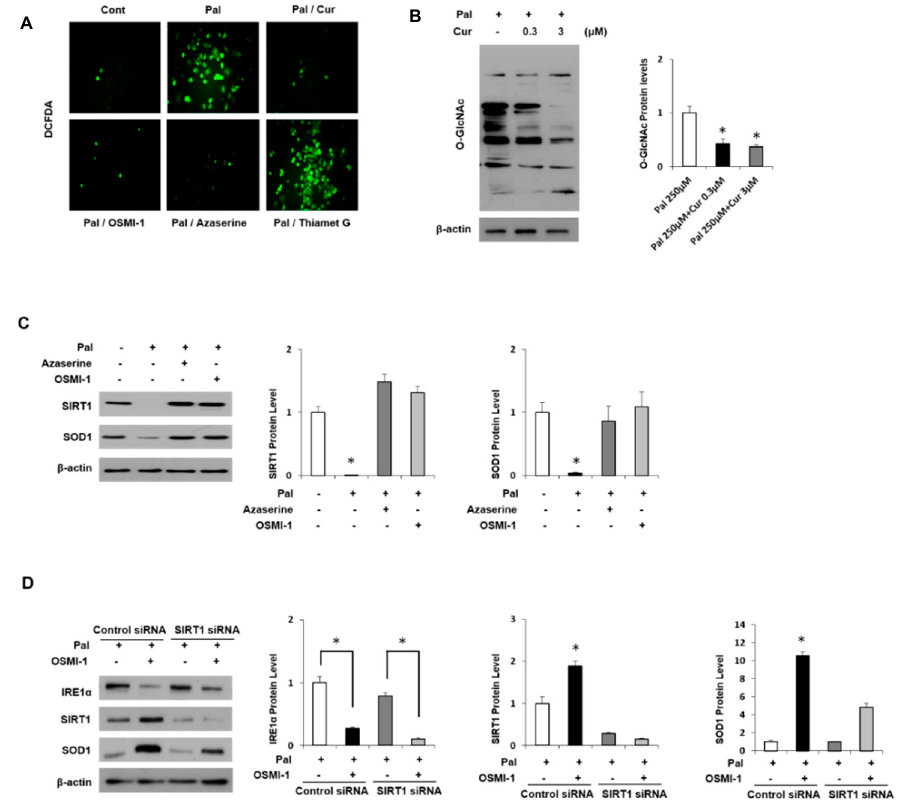
Figure 5. Regulation of O -GlcNAcylation and antioxidant protein in AML12 cells. ( A ) AML12 cells were either untreated or pretreated with 250 μ M palmitate (Pal) and incubated with curcumin (3 μ M), OSMI-1 (20 μ M), Azaserine (100 μ M) or Thiamet-G (200 μ M) for 12 h. The levels of ROS in cells were measured via DCFDA fluorescence. ( B ) AML12 cells were treated with Pal (250 μ M) and different concentrations of curcumin (0.3 or 3 μ M) to analyze the level of O- GlcNAcylated proteins by immunoblot assay. ( C ) The cells were either untreated or pretreated with 250 μ M Pal and incubated with Azaserine (100 μ M) or OSMI-1 (20 μ M) for 12h. Levels of SIRT1 and SOD1 expression were measured by immunoblot assay. ( D ) AML12 cells were transfected with control or SIRT1 siRNA for 24 h, and then the cells were treated with or without OSMI-1 (20 μ M), followed by incubation with 250 μ M Pal for 12 h. Levels of IRE1 α , SIRT1, and SOD1 expression were measured by immunoblot analysis. All expression levels were normalized relative to β -actin. The data from three independent experiments are presented as the means ± SD. * p < 0.05.